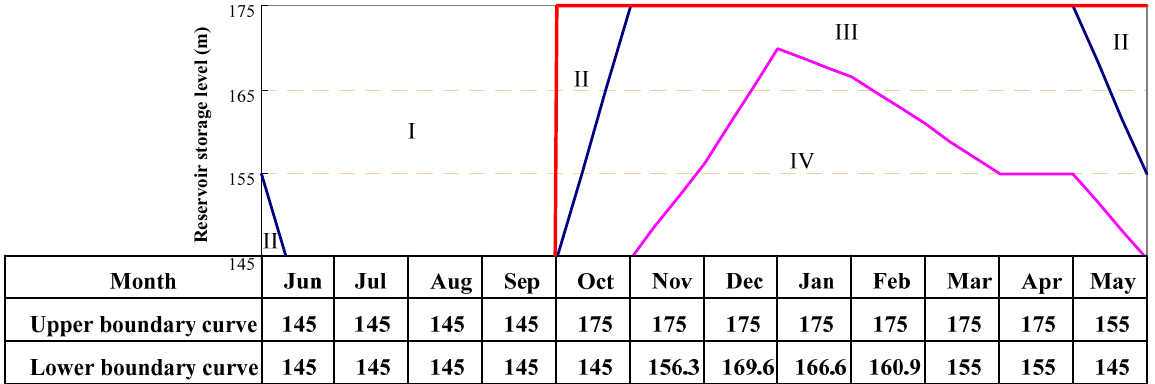
Figure 3. Designed operating rule curves of the Three Gorges reservoir.